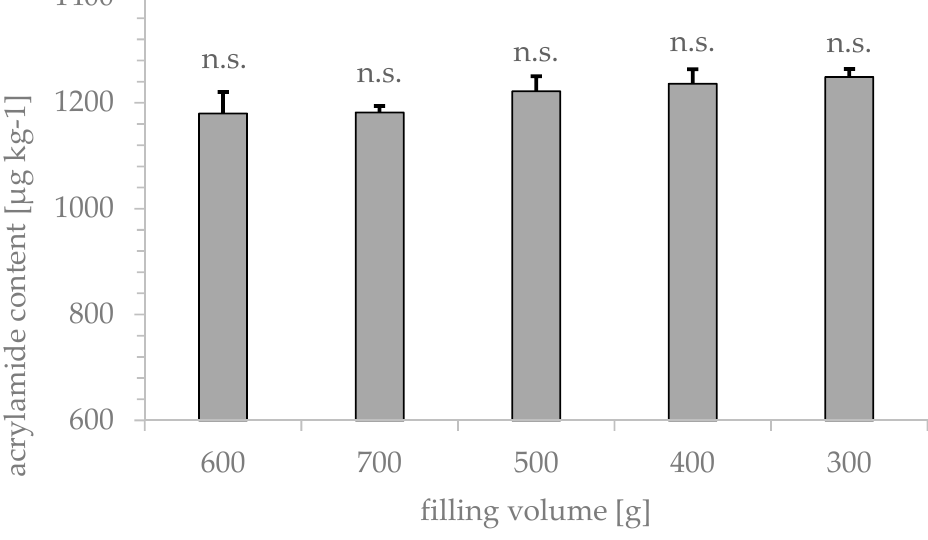
Figure 1. Impact of rye grain filling volume in the drum roaster on acrylamide content measured by GC-MS after xanthydrol derivatization. Whole grain samples (rye variety 4) were roasted at 190 °C for 13 min ( n = 5).